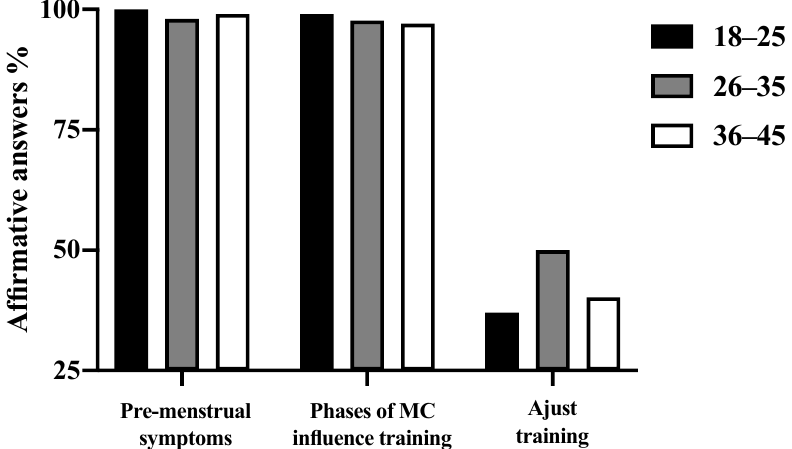
Figure 2. Percentages of women of different age-groups who reported feeling MC symptoms, who reported that MC phases influenced their training, and who indicated adjusting their training according to the MC phases.